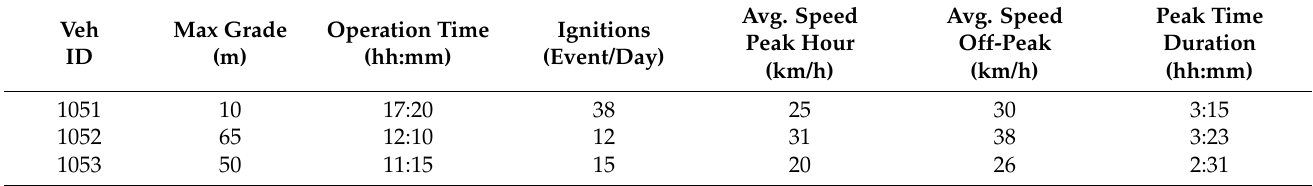
Table 6. Operational features of the tested fleet (selected vehicles and variables).